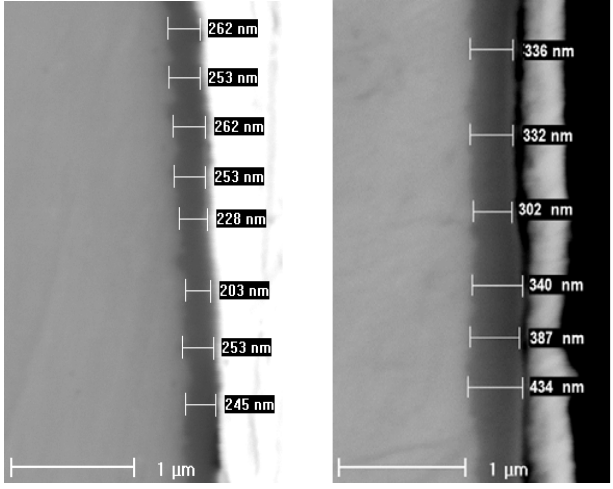
Figure 9. Scanning electron micrographs of the cross-section of oxides formed in WWER coolant without LiOH for 500 ( left ) and 720 h ( right ).